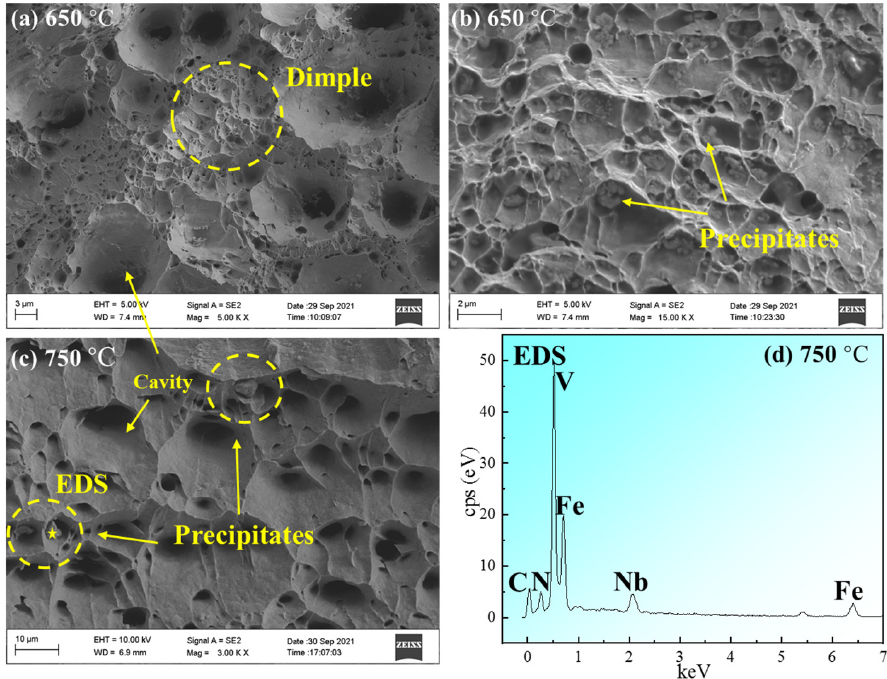
Figure 5. Typical SEM fractographs of T91 steel creep at ( a , b ) 650 °C, ( c ) 750 °C, and ( d ) is the energy spectrum analysis (EDS) of the second phase in ( c ).